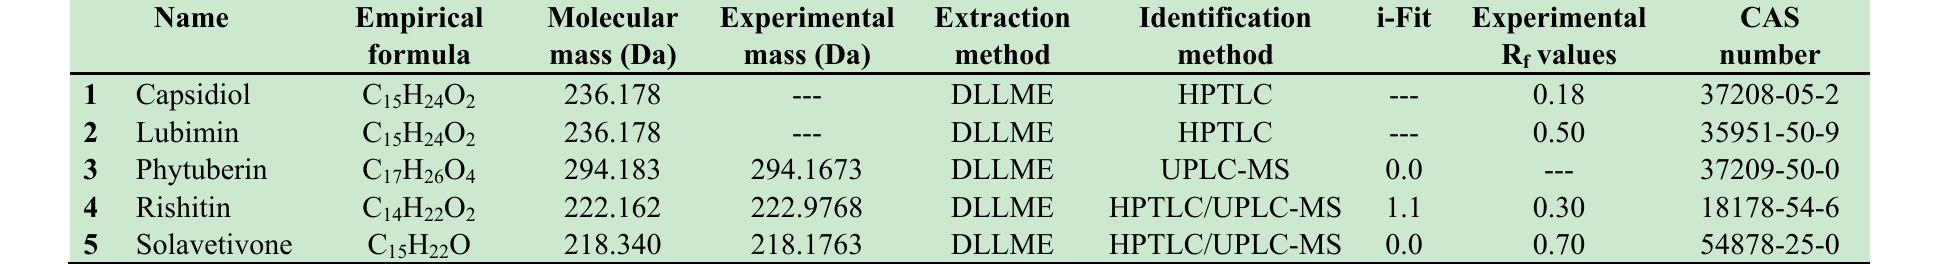
Table 1. Ergosterol-induced sesquiterpenoid phytoalexins in tobacco